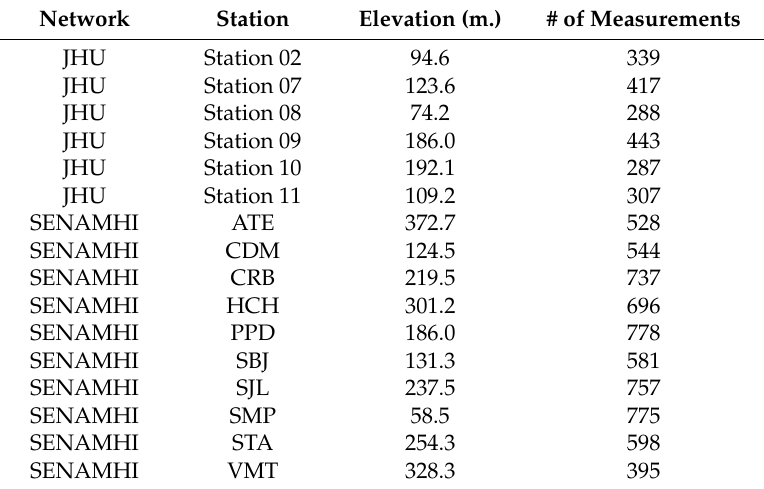
Table 1. PM 2.5 ground monitor information, elevation, and total number of observations at each monitor and their respective